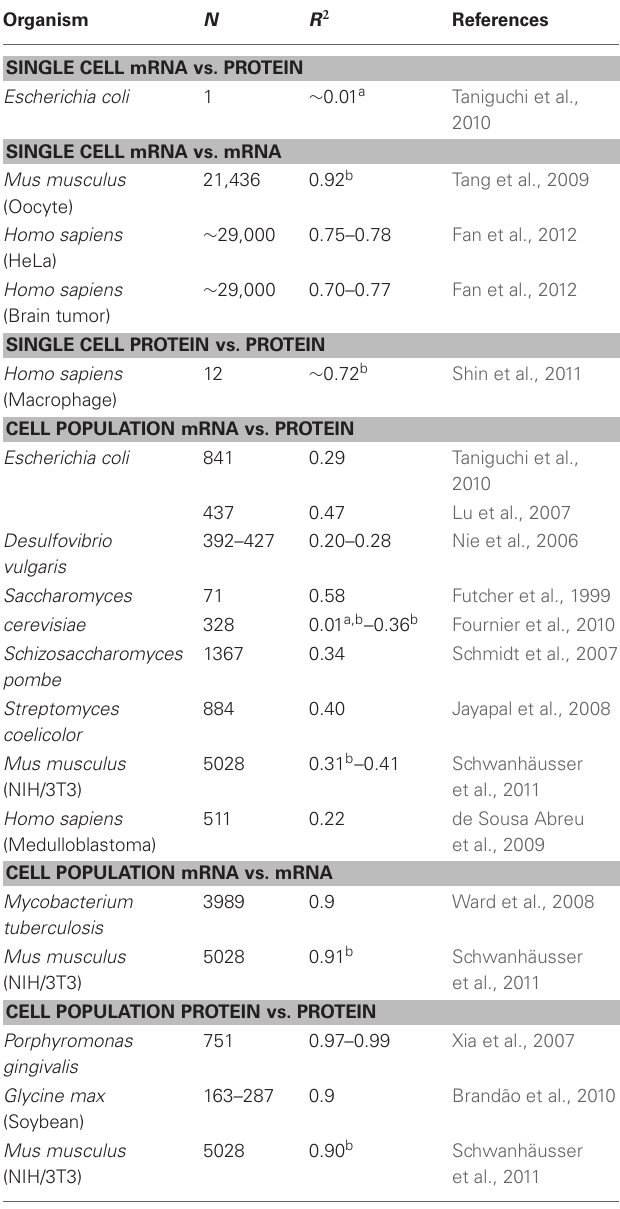
Table 1 | mRNA and protein expression correlations in various